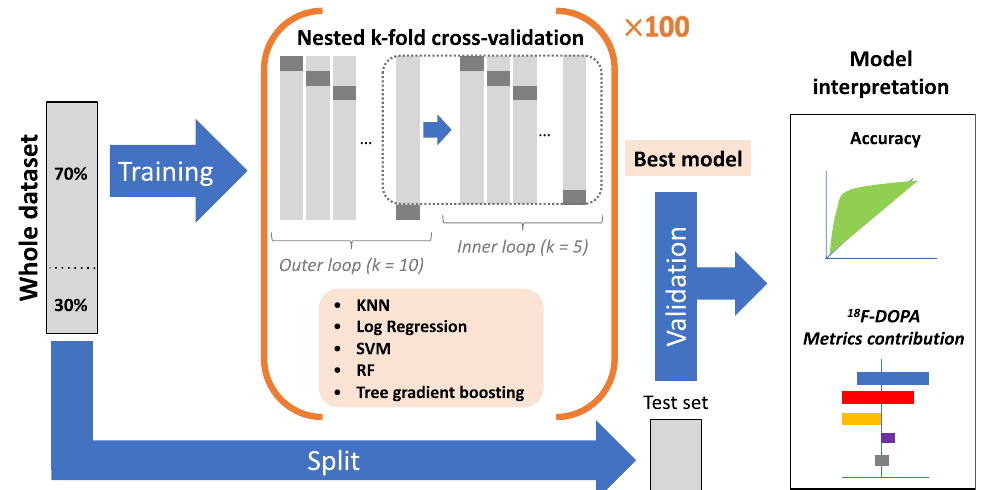
Fig. 3 Statistical analyses. After identifying potential collinearity between the PET metrics, the whole dataset (visual binary interpretation and semi-quantitative PET metrics from 110 18 F-DOPA PET/MRI) was split into training (70%) and test (30%) sets. Five machine learning classifiers (KNN, Log Regression-Log Reg, Support Vector Machine-SVM, Random Forest-RF and tree gradient boosting) were trained to predict the final diagnosis at 11 months of median follow-up (IPD or control) on the training set by using a nested k-fold cross-validation procedure. (Each model parameters are fine-tuned and cross-validated while optimizing the bias of over fitting.) The overall nested cross-validation procedure was repeated 100 times. The best model on average was applied on the test set to provide general unbiased accuracy. Finally, the contribution of each 18 F-DOPA PET parameter (the visual and four semi-quantitative metrics) in the model predictions was